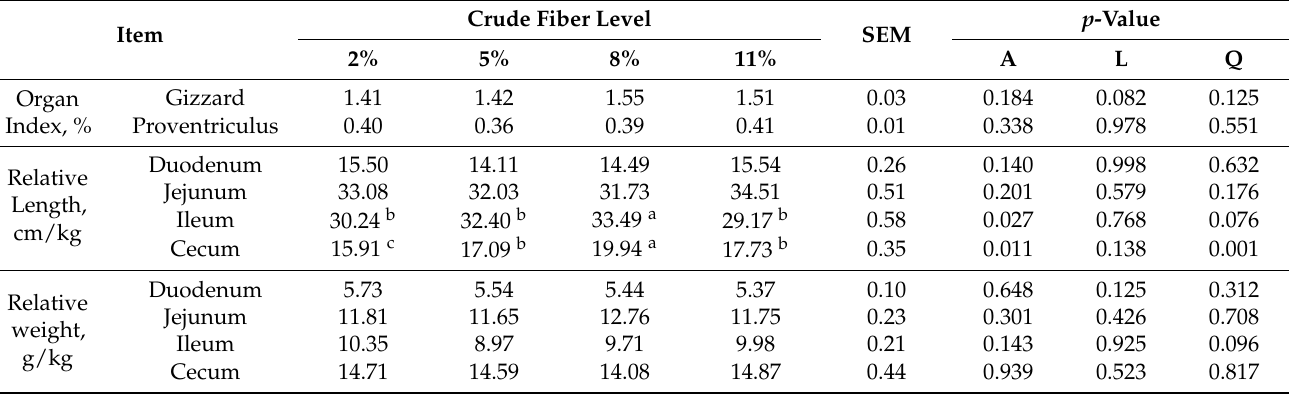
Table 8. Effects of dietary CF level on gastrointestinal development of broilers on day